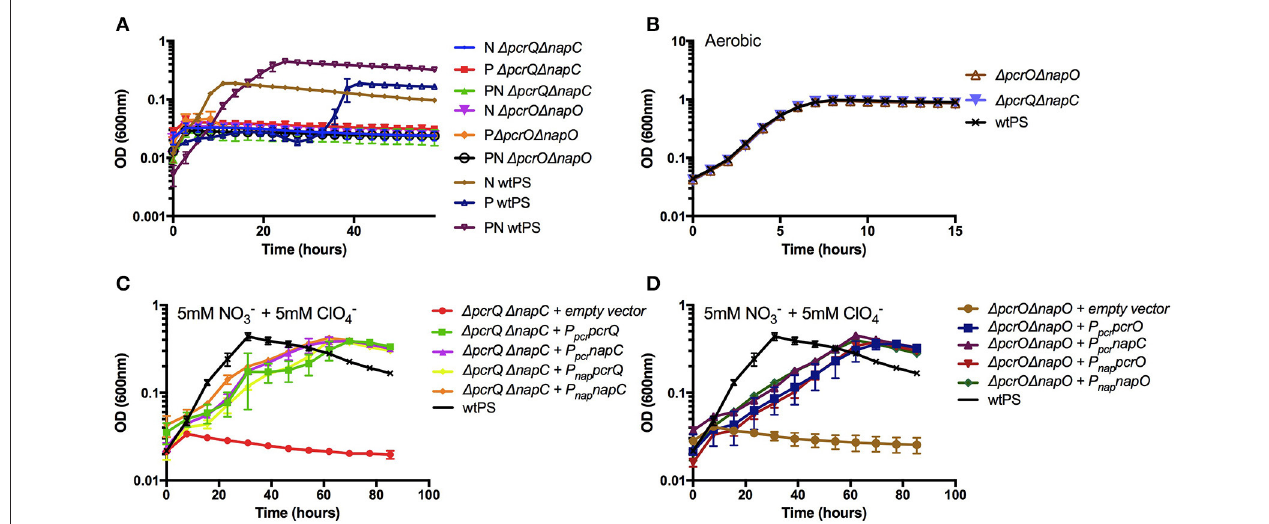
FIGURE 3 | Growth of ∆ pcrQ ∆ napC and ∆ pcrO ∆ napO . (A) Growth phenotype of wtPS, ∆ pcrQ ∆ napC, and ∆ pcrO ∆ napO on LMM medium containing nitrate (N), perchlorate (P), both nitrate and perchlorate (PN), and (B) oxygen were tested. (C,D) Growth of ∆ pcrQ ∆ napC with complementation vectors expressing pcrQ or napC , and ∆ pcrO ∆ napO with complementation vectors expressing pcrO or napO on LMM medium with nitrate and perchlorate. Complementation tests were conducted with either pcr or nap promoter (P pcr and P nap ). Error bars represent standard deviations of biological triplicate samples.